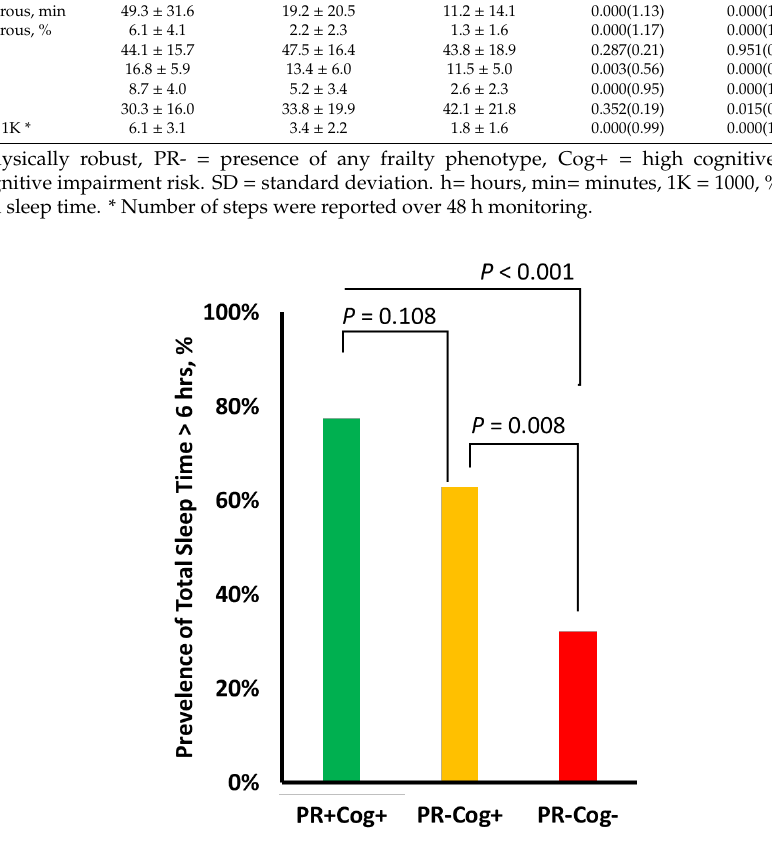
Figure 2. The prevalence of cases with total sleep time exceeding 6 h per night in each of the three groups: physically robust and high cognitive function (PR + Cog + ), signs of physical frailty with high cognitive function (PR-Cog + ), and signs of physical frailty with risk of cognitive impairment (PR-Cog-), defined as cognitive frailty in this study. Lowest significant sleep deprivation was observed in the cognitive frailty group.